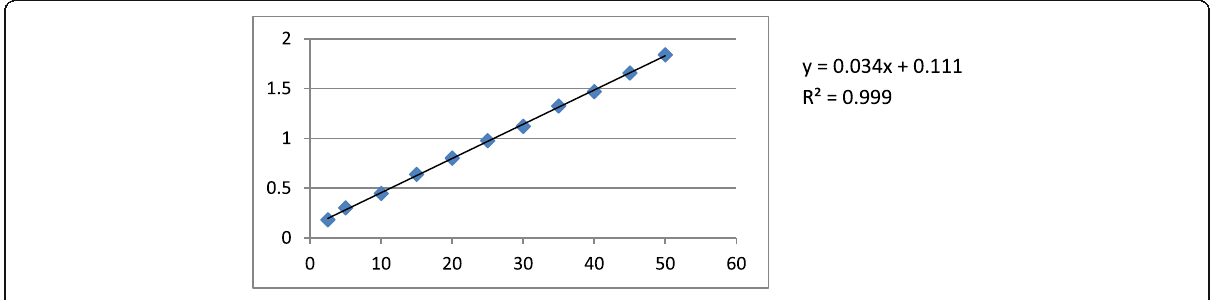
Fig. 6 Standard calibration curve of gallic acid